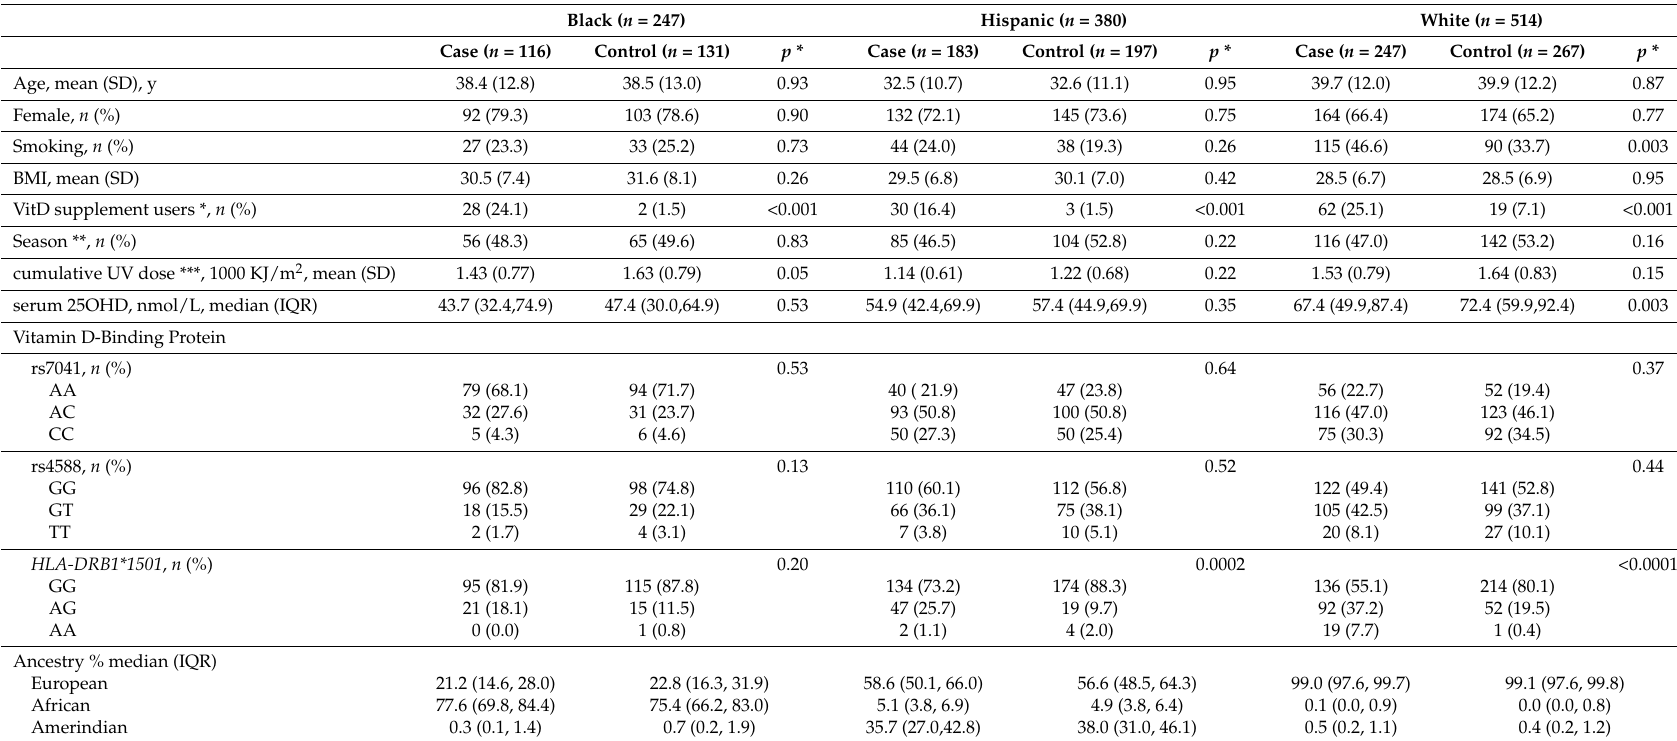
Table 1. Selected characteristics at symptom onset/index date of MS/CIS cases and controls by